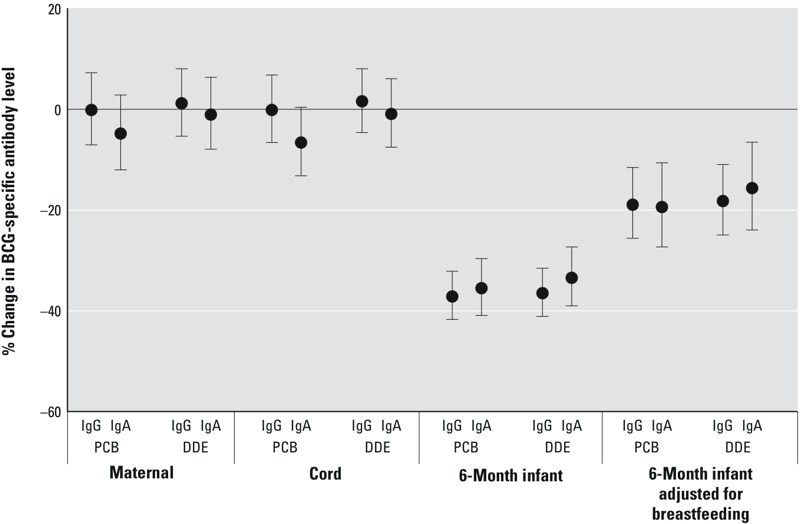
Measured maternal, cord, and 6-month infant serum PCB and DDE concentrations and the percent change (95% CI) in 6-month BCG-specific IgG and IgA levels for an interquartile range difference in each exposure. Maternal and cord serum models are adjusted for maternal ethnicity, education, age, smoking, and parity. Six-month infant models are adjusted for maternal ethnicity, education, and age. A second 6-month model includes maternal ethnicity, education, age, and the duration of exclusive breastfeeding. Interquartile ranges as well as crude and adjusted numerical estimates are available in Table S1.